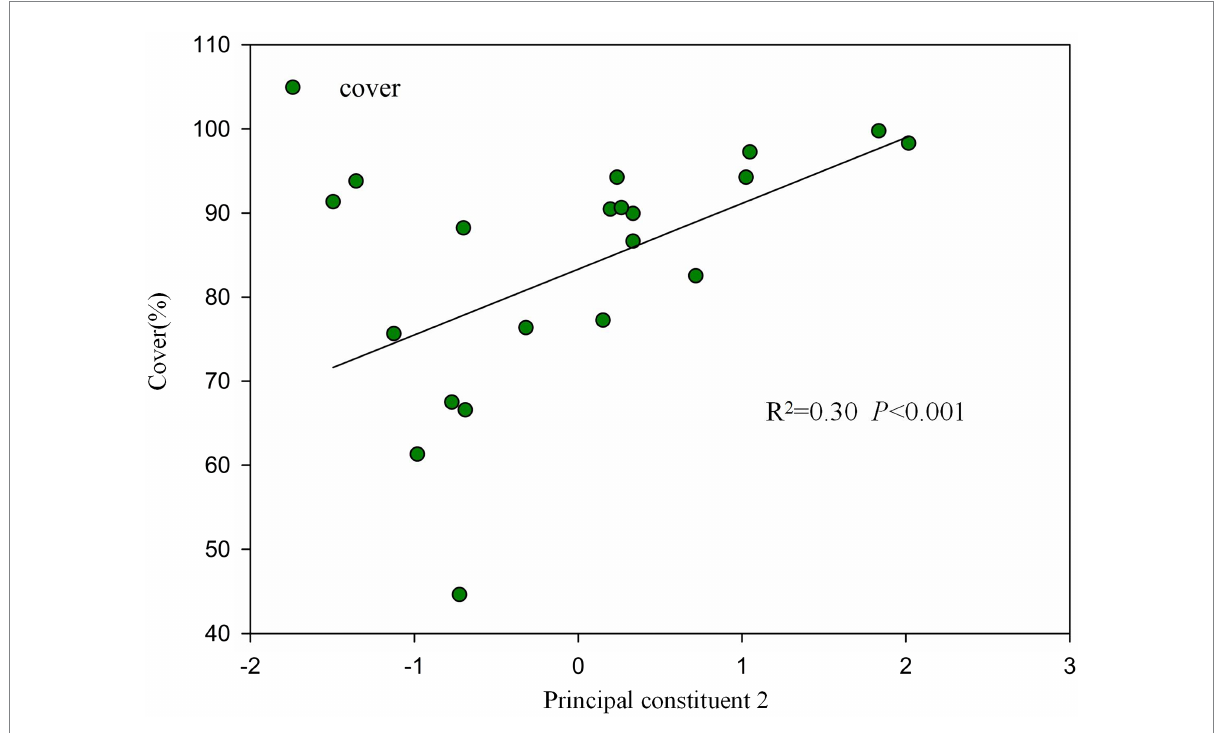
FIGURE 4 Relationships between forage cover and Principal component